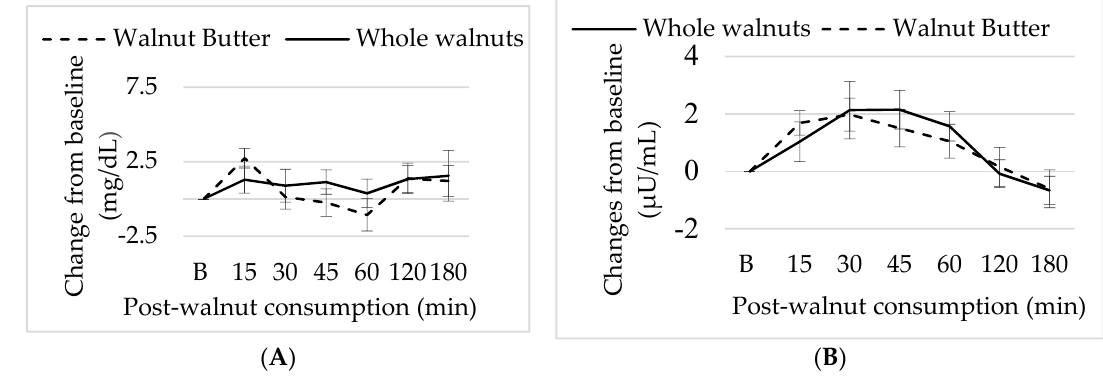
Figure 5. Mean ± S.E.M changes in ( A ) insulin and ( B ) glucose concentration subsequent walnut consumption.